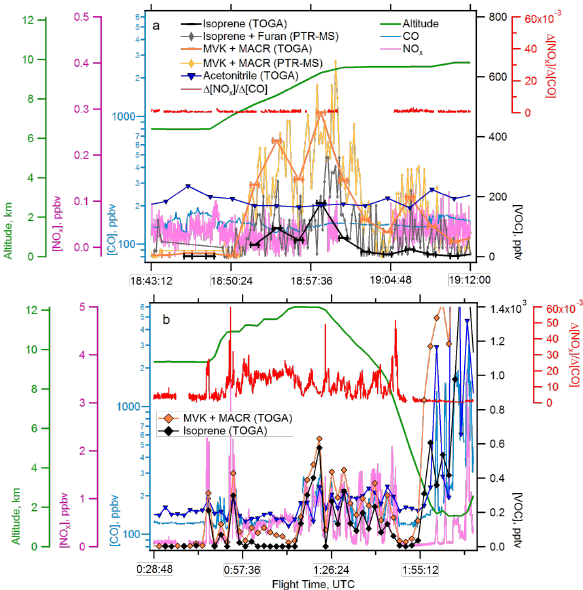
Fig. 4. Expanded view time series plot of a number of parameters for (a) event 1 and (b) event 2. See Table 1 for information on the techniques used to make these measurements. The bars representing the TOGA isoprene and MVK + MACR measurements indicate the integration time for sample collection (40 s). See text for a full